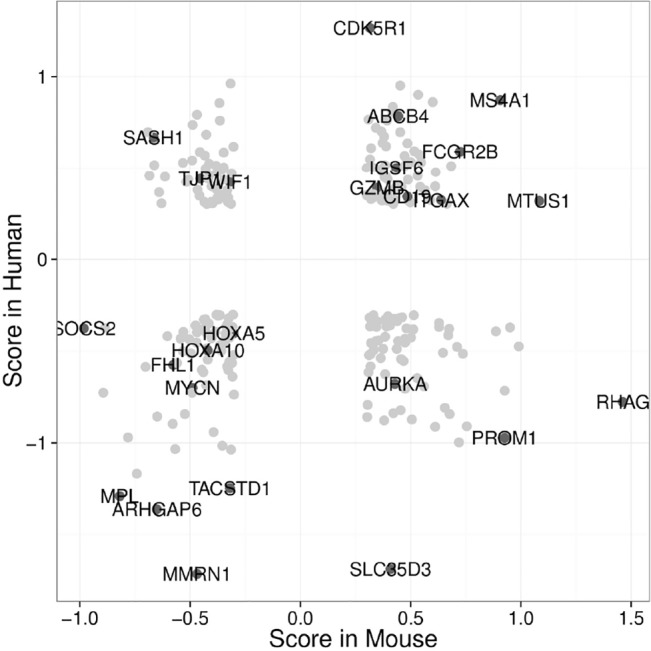
Comparison of dnMpl LSK cells and of CD34+ cells of aplastic anemia patient.(A) Expression scores of each gene in murine dnMpl mice and human RC and SAA patients CD34+ cells were compared. Negative scores in both cases (lower left quadrant) reflect the downregulation of genes typically associated with a healthy phenotype. Differentially expressed genes (lower right and upper left quadrant) may reflect species/disease differences. Score: (expression sample–expression control)/(SD sample + SD control). Gene lists referring to each quadrant in the supplements.